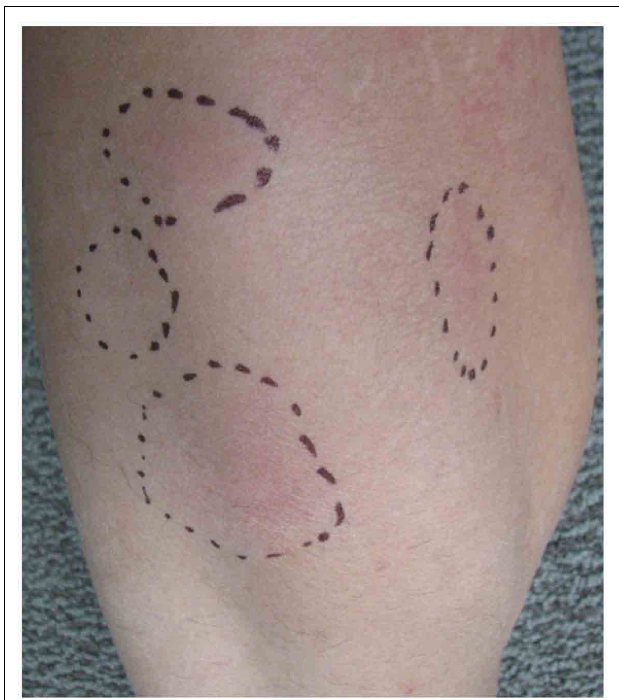
FIGURE 3 | Erythema nodosum manifested as erythematous nodules of the skin. These lesions are often painful and assume a bruise-like